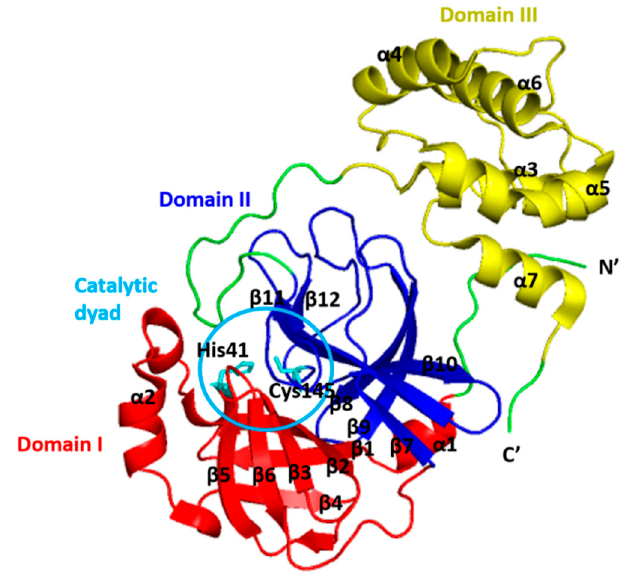
Figure 3. Domain organization of the monomeric structure of the SARS-CoV-2 3CLpro. Domain I (residues 8–101) is coloured in red, domain II (residues 102–184) is coloured in blue and domain III (residues 201–303) is coloured in yellow. The catalytic dyad (His14 and Cys145) of 3CLpro is shown in stick (indicated by circles)